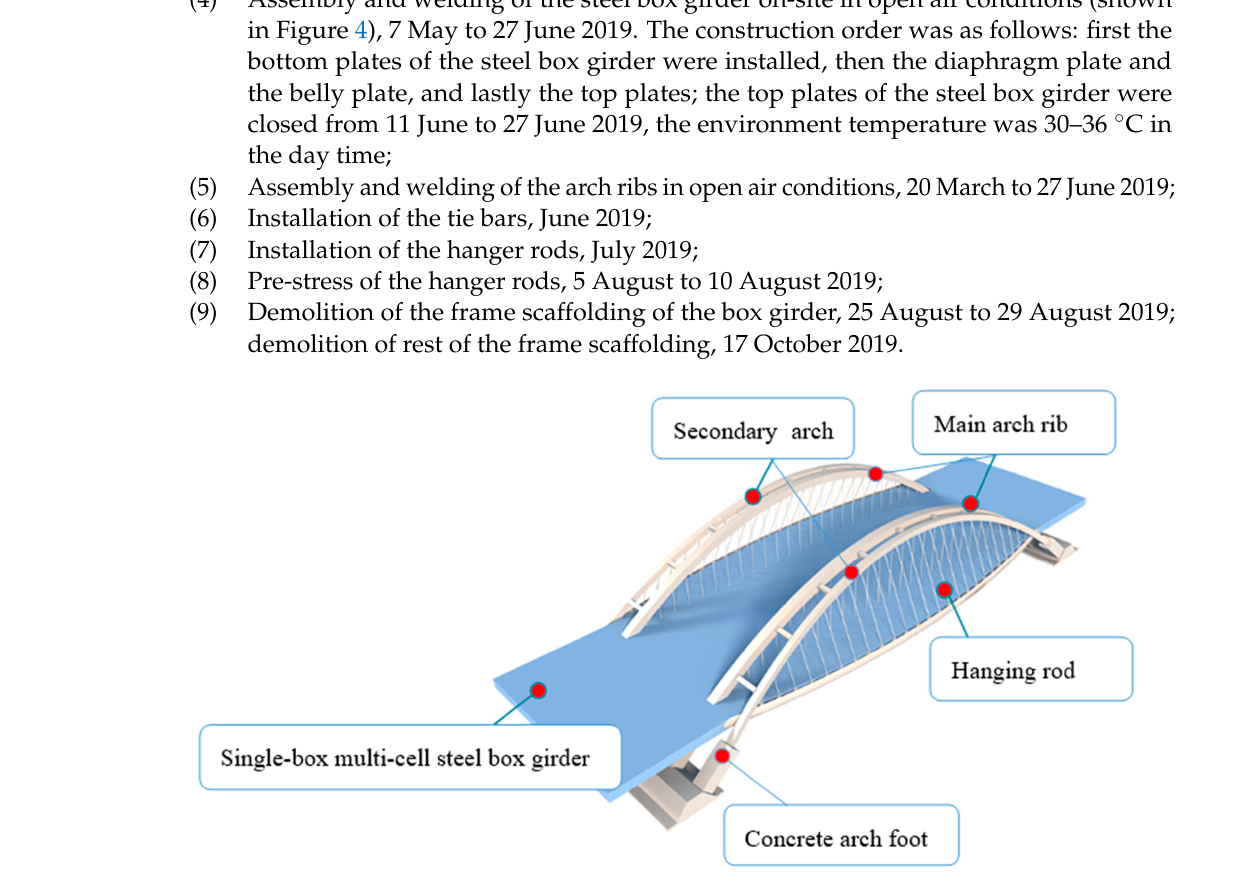
Figure 1. 3-D view of the bridge.